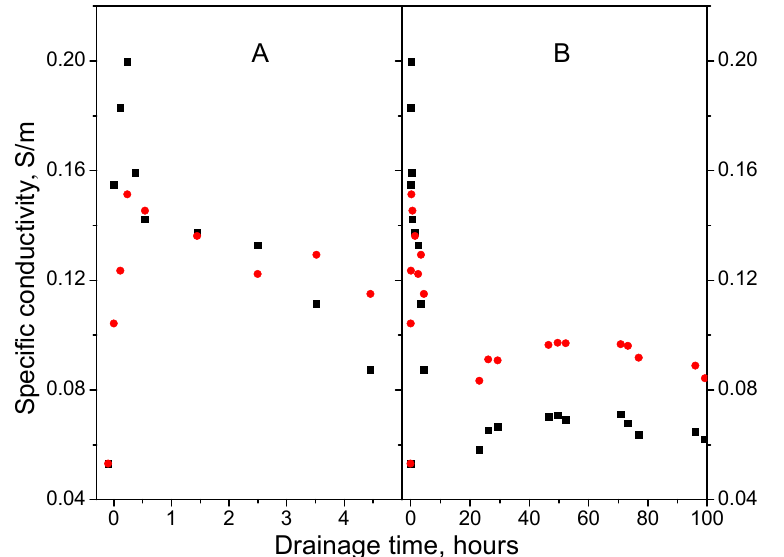
Figure 9. Experiment 1. Dependence of conductivity on water drainage time on a narrow ( A ) and wide ( B ) time intervals. The values of n were used, calculated for the near-surface layer of sand using Equation (5) (red circles ● ) and on average for the entire layer of sand using Equation (8) (black squares ■ ).